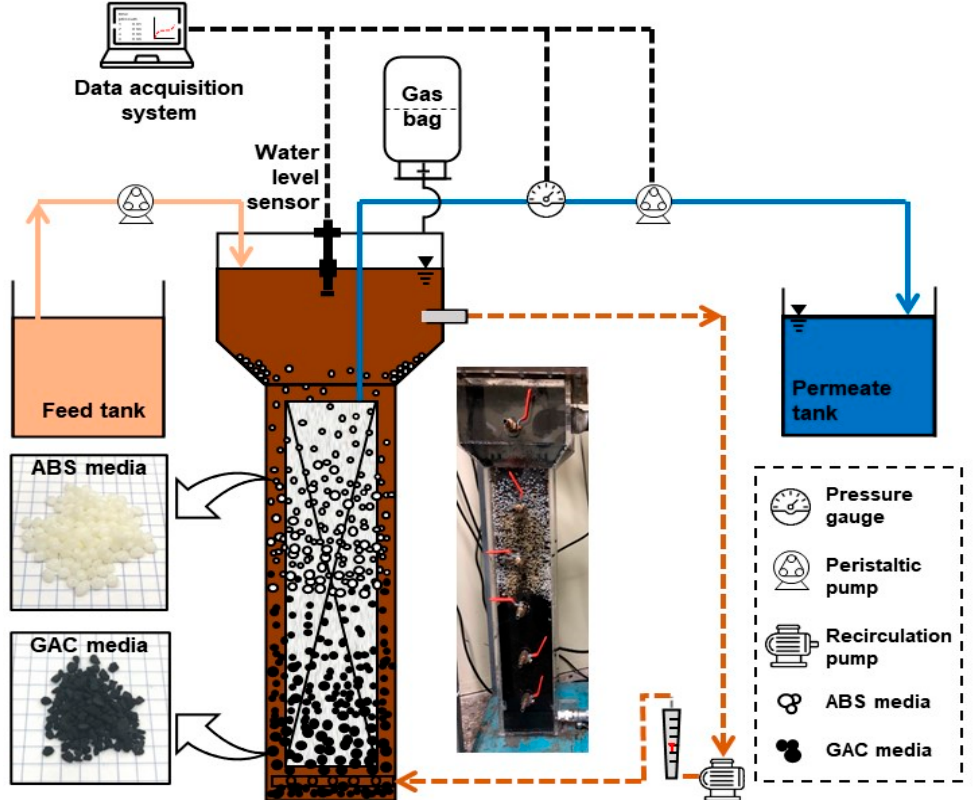
Figure 1. Schematic diagram of AFMBR with the dual media process.